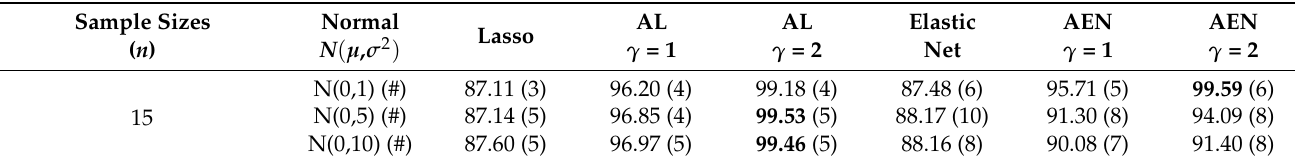
Table 2. The average percentage of accuracy and the average number of selected variables (#) of lasso, adaptive lasso (AL), elastic net, and adaptive elastic net (AEN) under 20 variables.